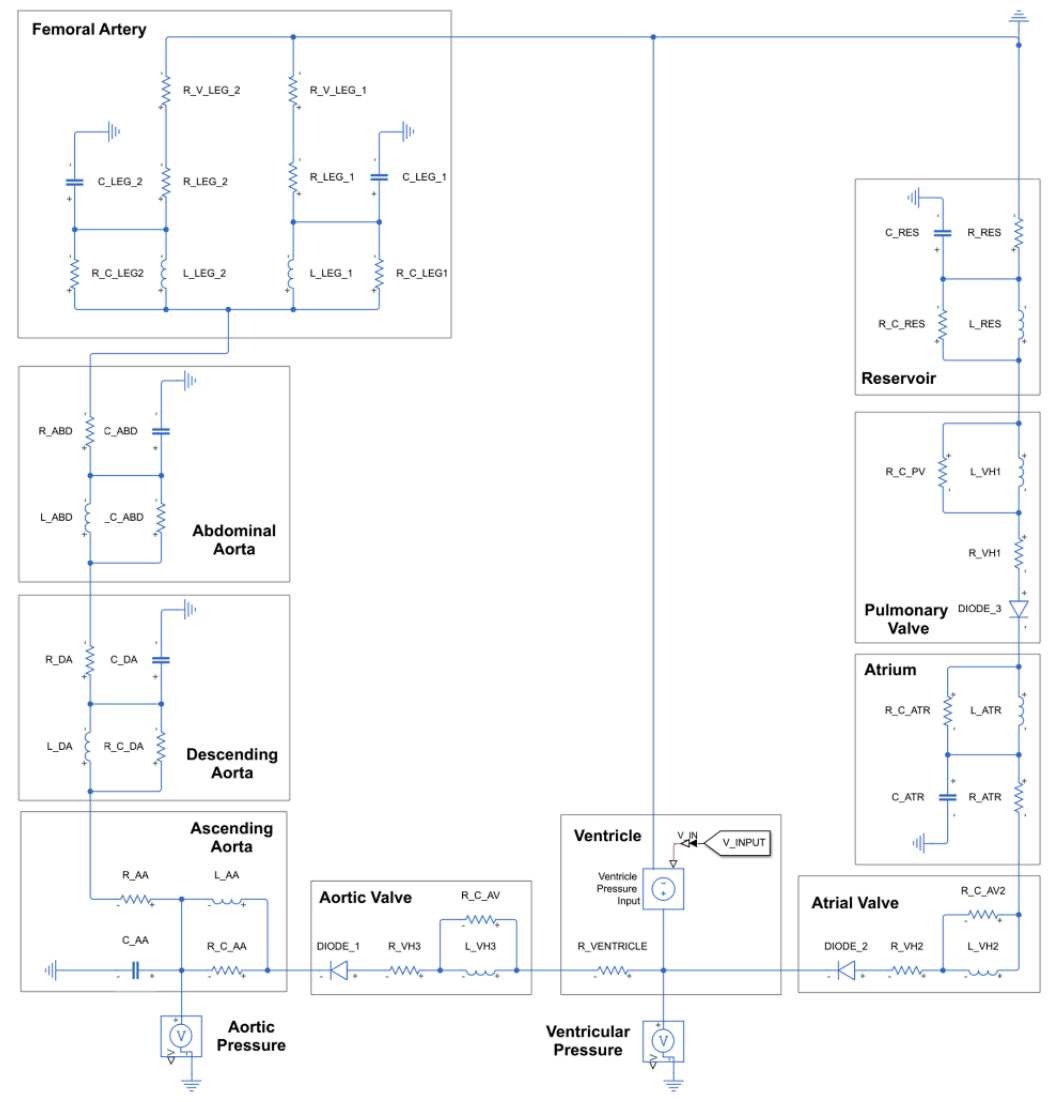
Figure 6. Simulation model of the mock circulatory platform.